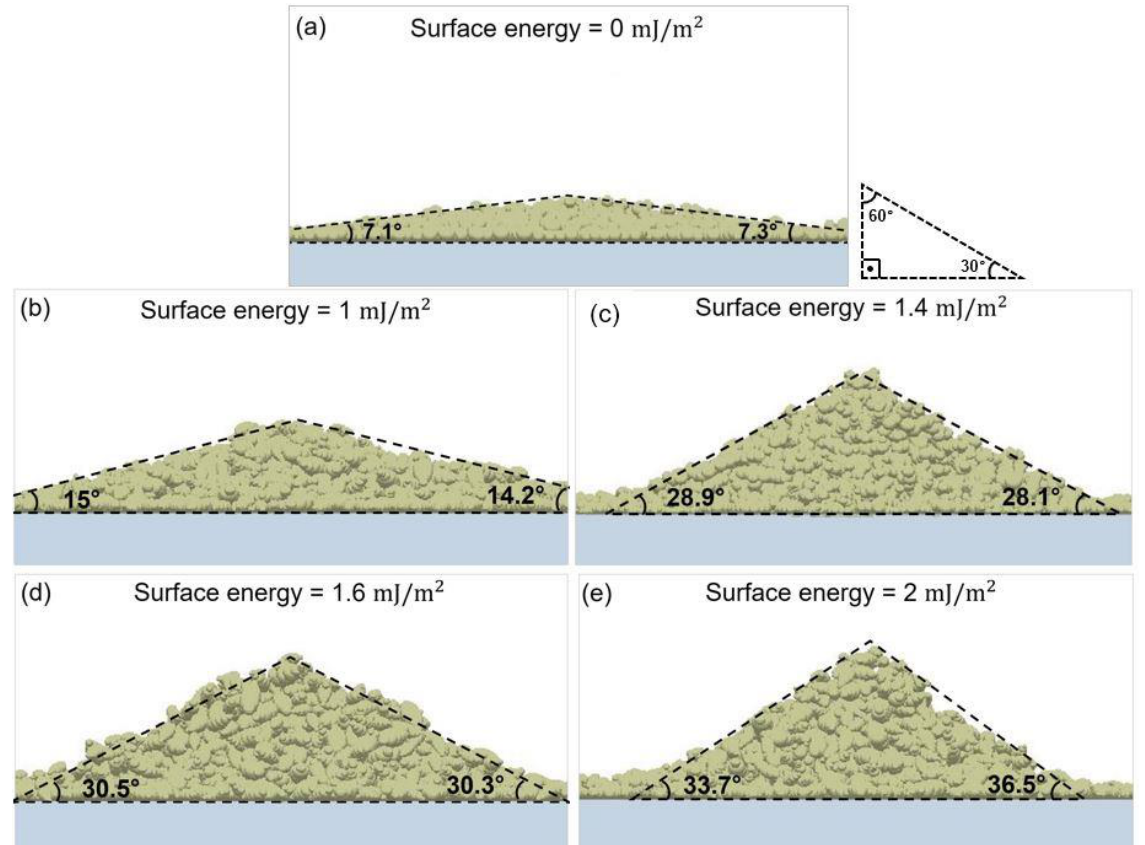
Figure 12. The hillside angle of the as-received powder under surface energy values of ( a ) 0, ( b ) 1, ( c ) 1.4, ( d ) 1.6 and ( e ) 2 mJ/m 2 . ( c ) 1.4, ( d ) 1.6 and ( e ) 2 mJ/m 2